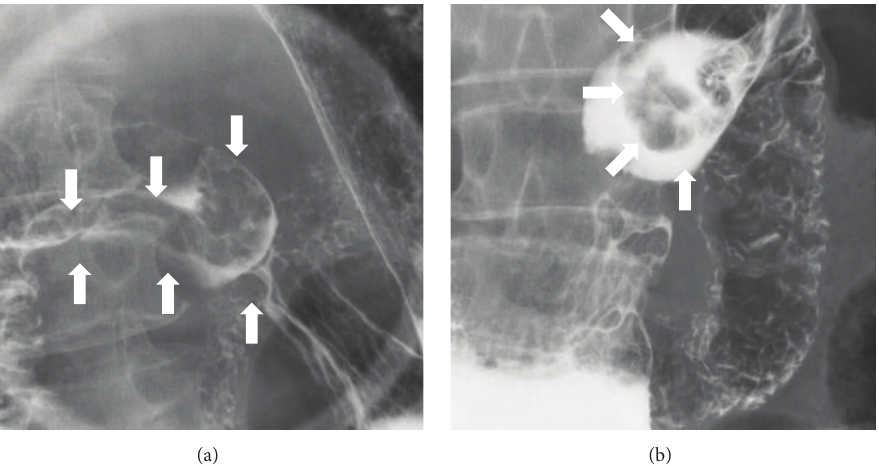
Figure 1: Barium follow-through examination images. A pedunculated polyp can be identified in the duodenum (arrows).